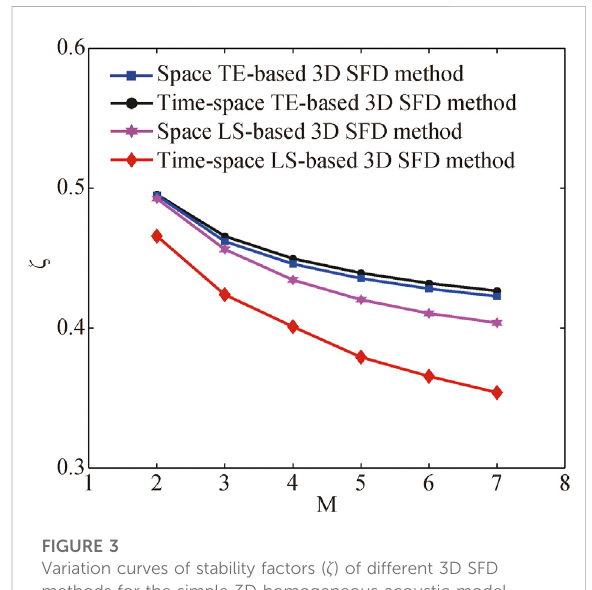
FIGURE 3 Variation curves of stability factors ( ζ ) of different 3D SFD methods for the simple 3D homogeneous acoustic model (Model A).